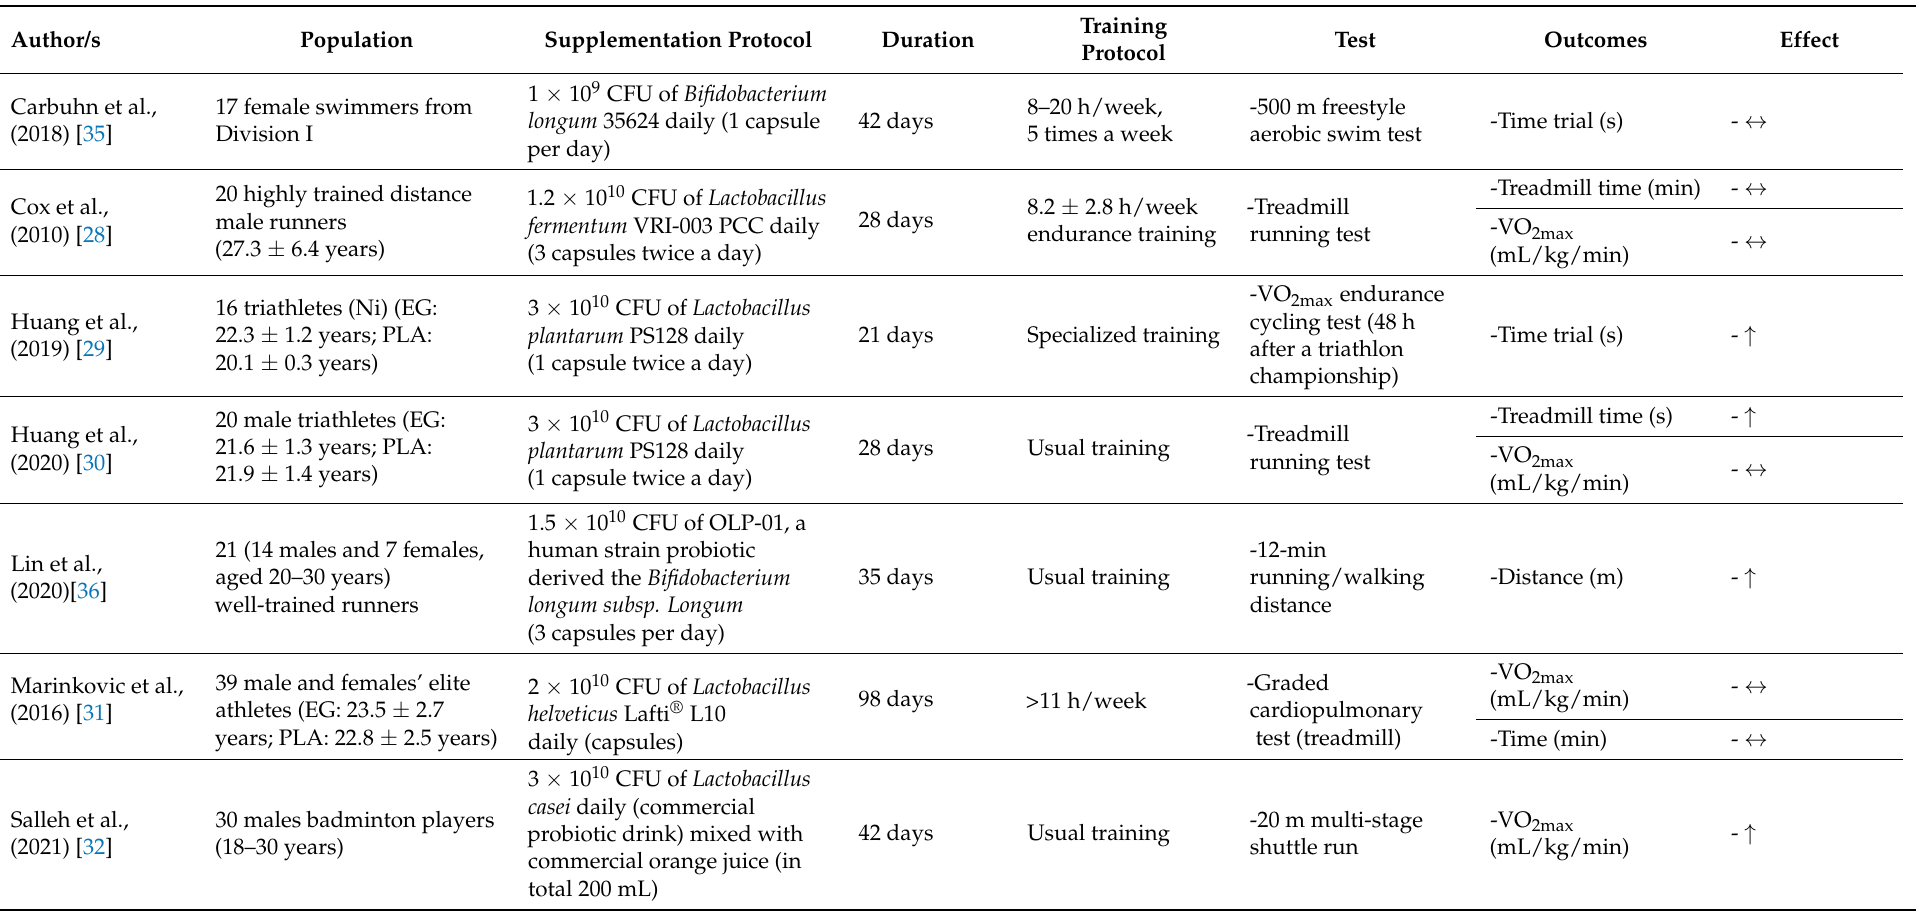
Table 3. Summary of the studies included in the systematic review that investigated the effect of single strain probiotics on exercise in which aerobic metabolism is predominant ( ≥ 5